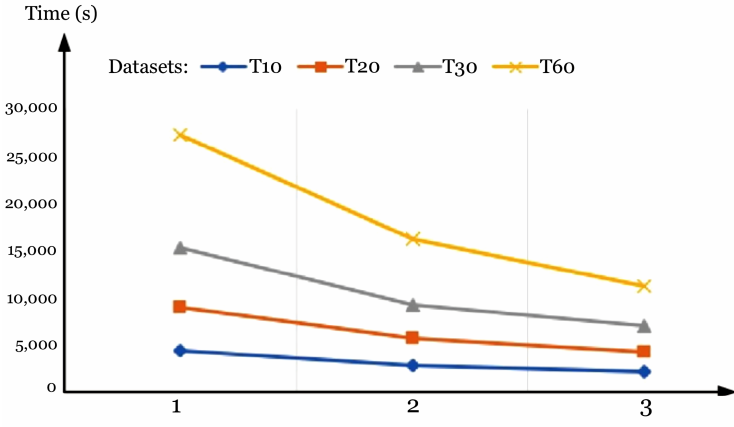
Figure 18. Execution time in seconds for Scenarios